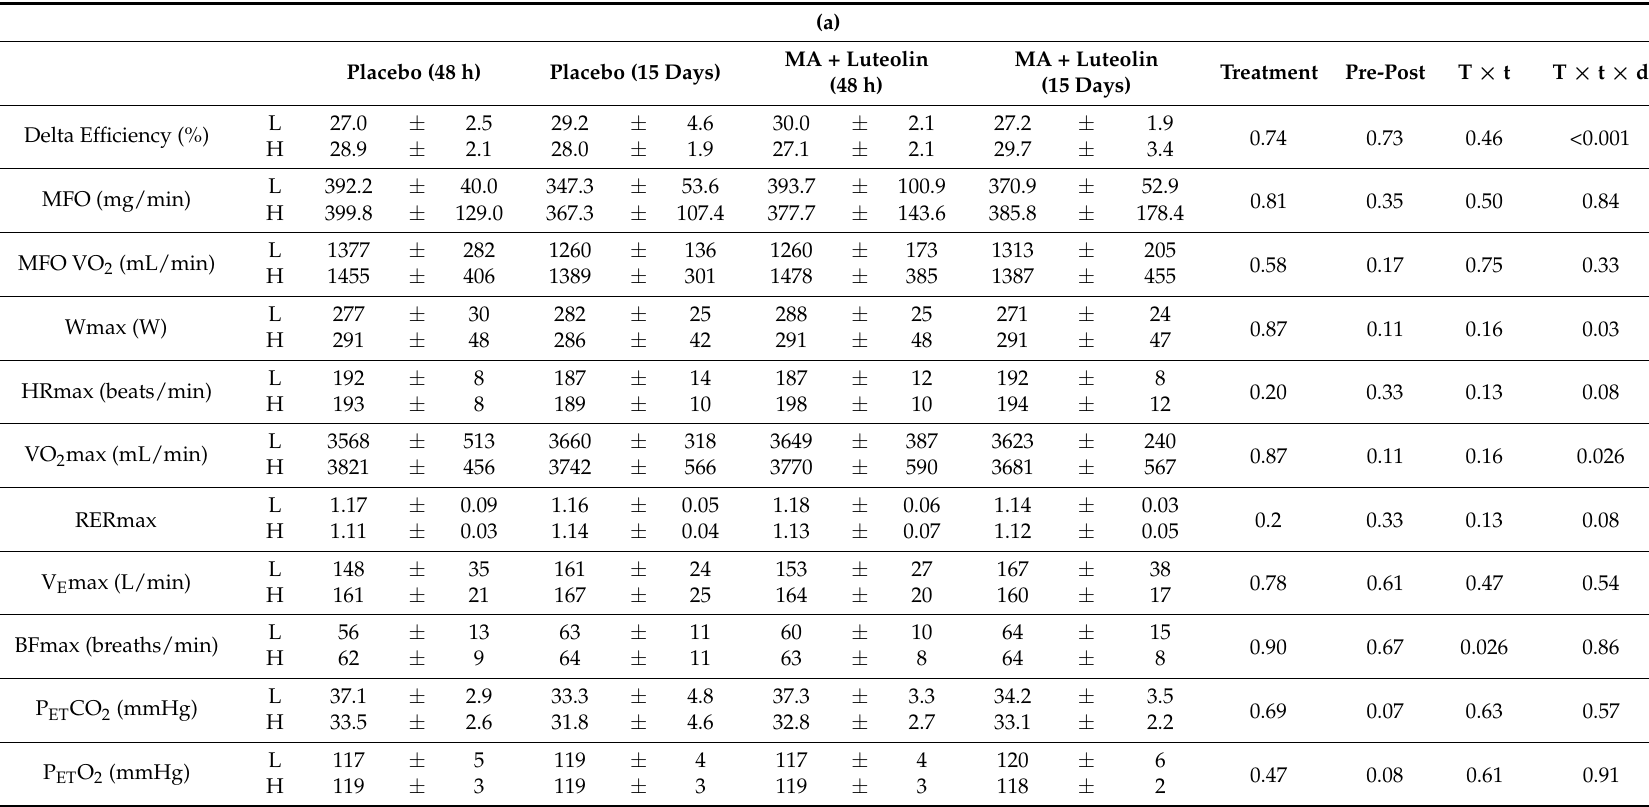
Table 1. (a) Effects of mangiferin and luteolin botanical extracts on muscle energy efficiency, heart rate, performance, and pulmonary gas exchange during incremental exercise to exhaustion. (b) Effects of mangiferin and luteolin botanical extracts on muscle energy efficiency, heart rate, performance, and pulmonary gas exchange during incremental exercise to exhaustion and the final time